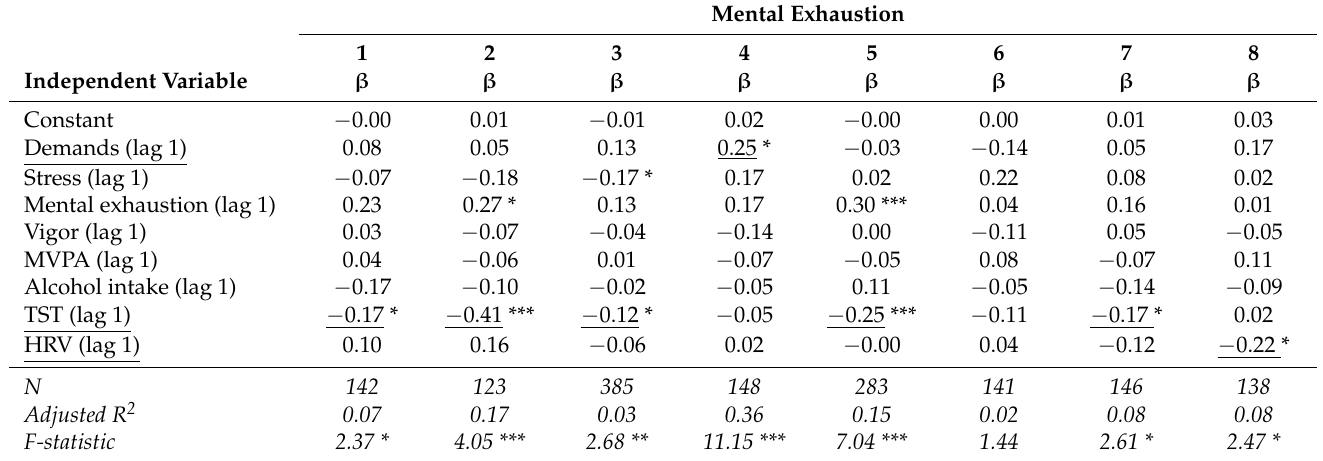
Table 6. Vector autoregression models for mental exhaustion per participant (1–8). Mental